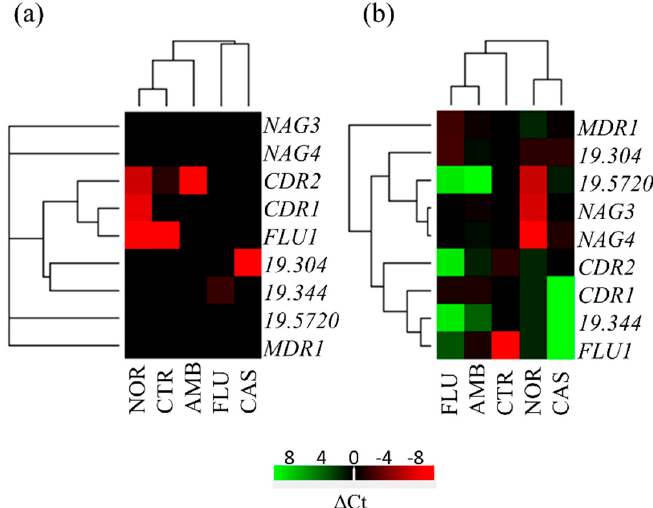
Figure 4. Heat-maps showing the expression changes in a mature biofilm of known drugs transporters ( MDR1 , CDR1 , CDR2 ), or of the least characterized ones ( FLU1 , 19.5720 , NAG3 , NAG4 , 19.304 , 19.344